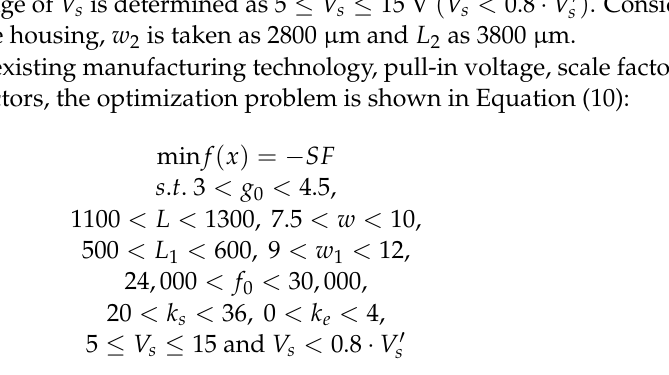
Table 1. Structural parameters of the accelerometer. Parameter Values Units Structural layer thickness 60 µ m Driving comb length 20